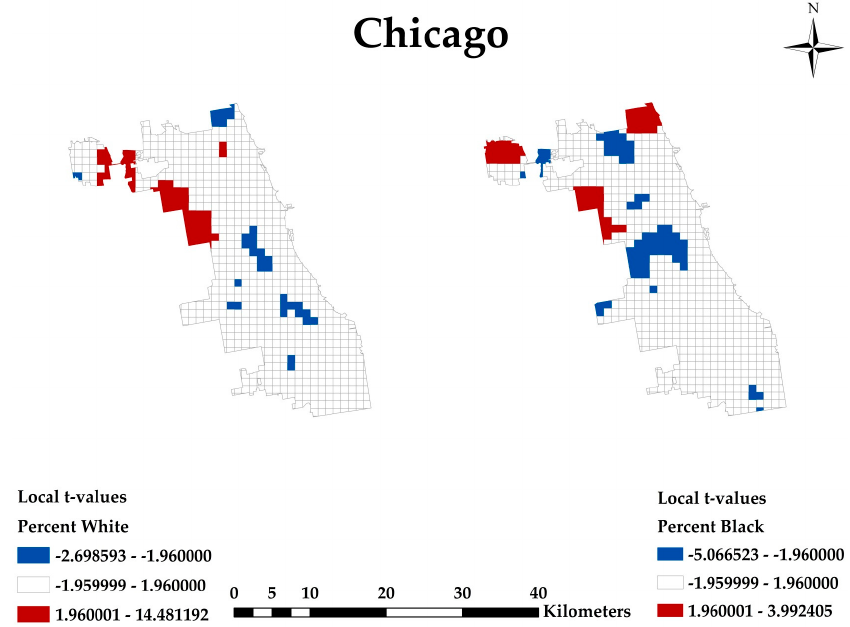
Figure 8. Chicago shrinking city Percent White and Percent Black: 95% two-tailed test ( − 1.96:1.96).